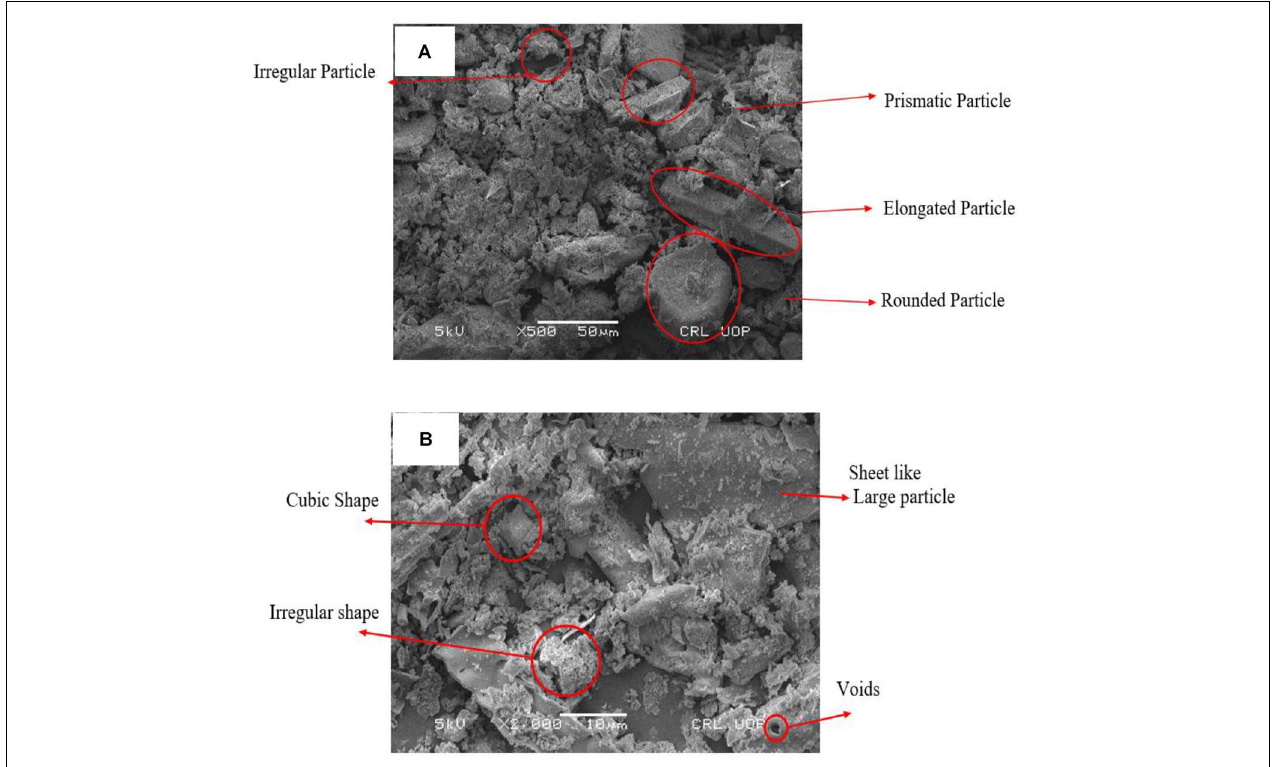
FIGURE 4 | SEM images of bagasse ash after grinding in a ball mil: (A) the presence of different particle shapes and (B) the presence of small, flat irregular, needle-shaped, and elliptical particles.